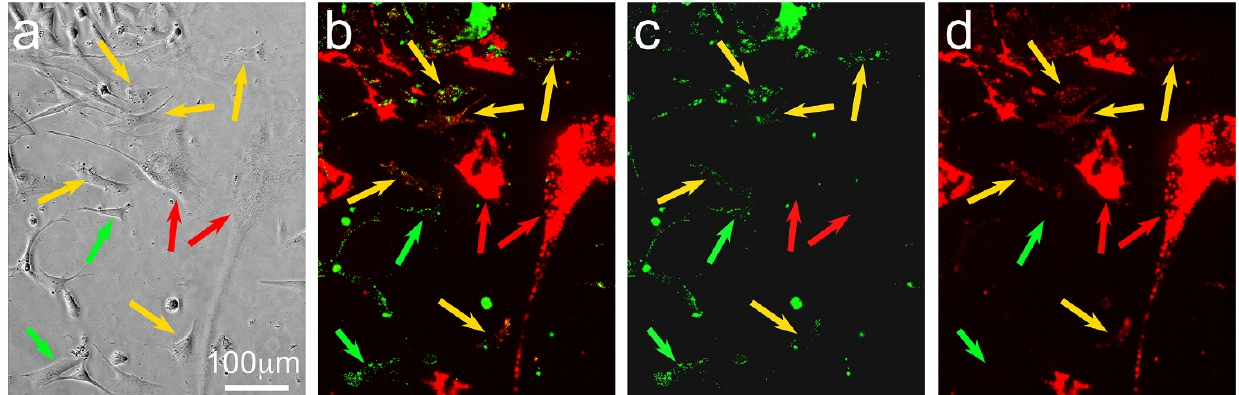
Figure 1. Photomicrographs of a visual field of pre-labelled SAOS-2 cells (fluorescent green marker) co-cultured with pre-labelled HDFs (fluorescent red marker) at the 20 h time point, showing phase-contrast ( a ) and fluorescent images with red and green channels combined ( b ), as well as green ( c ) and red ( d ) channels alone. The lipophilic fluorescent markers were concentrated in organelles, creating a typically punctate appearance ( b – d ), so that phase-contrast images ( a ) were more helpful for identification of cell margins. HDFs were clearly red-labelled (red arrows), while SAOS-2 cells were green-labelled. Comparison of combined and separated channels for fluorescence images demonstrates that some SAOS-2 cells had no red HDF fluorescent label (green arrows), while others had received appreciable levels of the red HDF marker (yellow arrows).